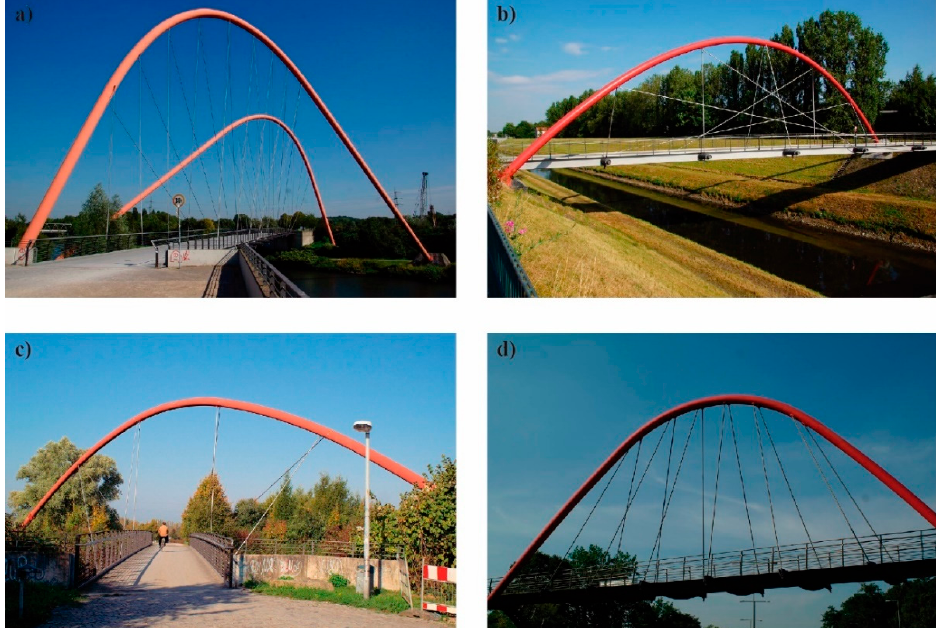
Figure 8. ( a ) Nordsternpark Double Arch, ( b ) Nordsternpark Arch Bridge, ( c ) Lehrhovebruch Footbridge, and ( d ) TZU Footbridge. Photos: Nicolas Janberg, structurae.net (accessed on 17 Decem- ber